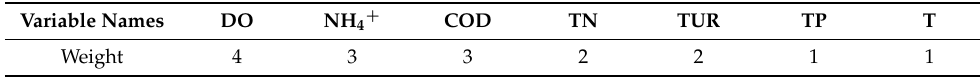
Table 5. Weight assignment of each water quality parameter.